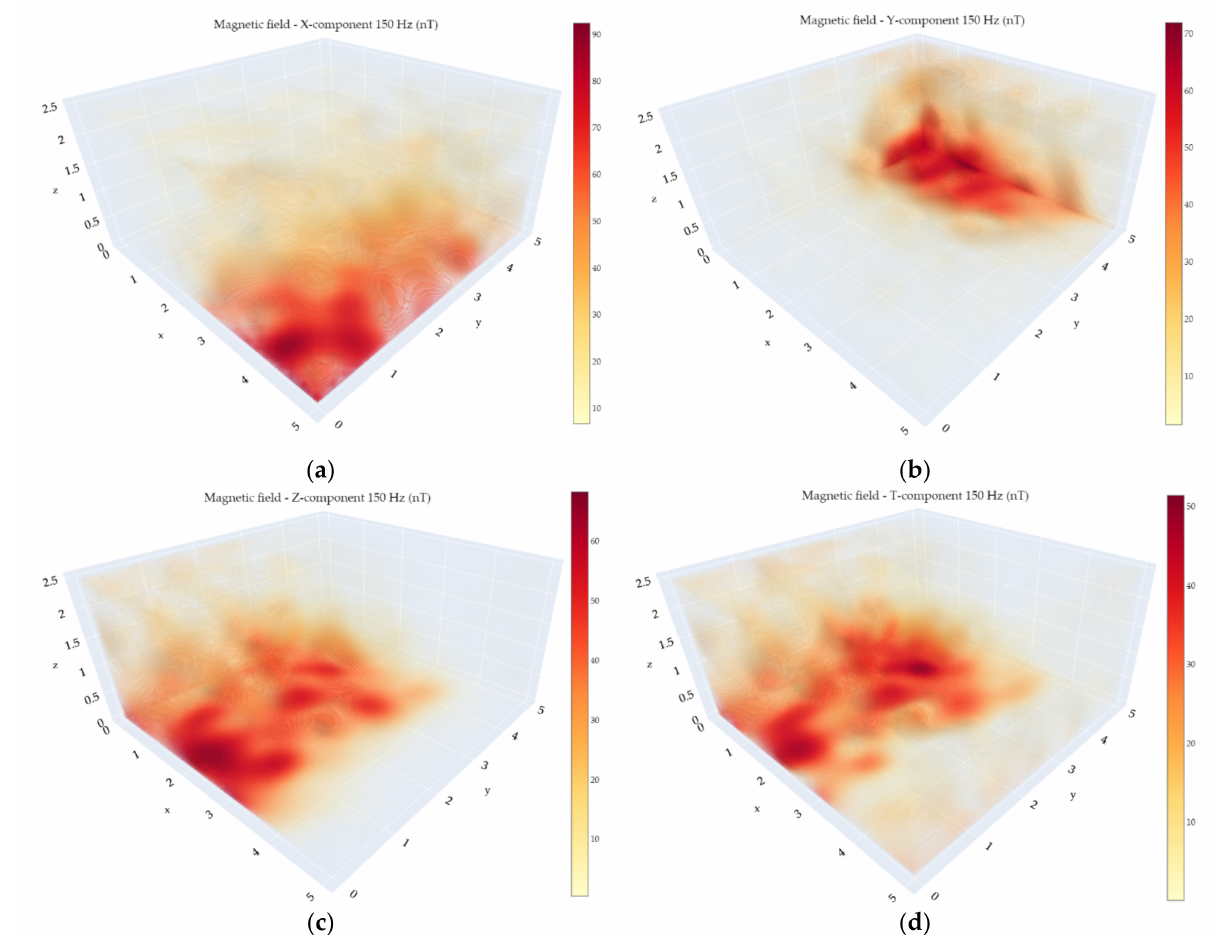
Figure 15. 150 Hz amplitudes of the magnetic field measured with the VEMA magnetometer: ( a ) X-component; ( b ) Y-component; ( c ) Z-component; ( d )